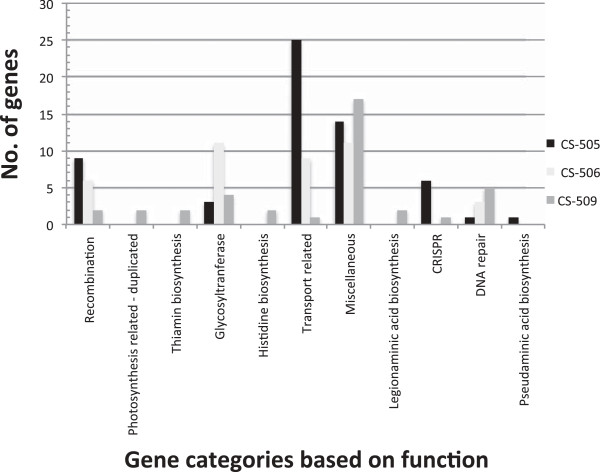
Classification of strain-specific genes in the study strains possibly associated with ecophysiological adaptations. Miscellaneous category represents peptidases, proteases, methyltransferases, and and folate, thiamin and cell wall biosynthesis.